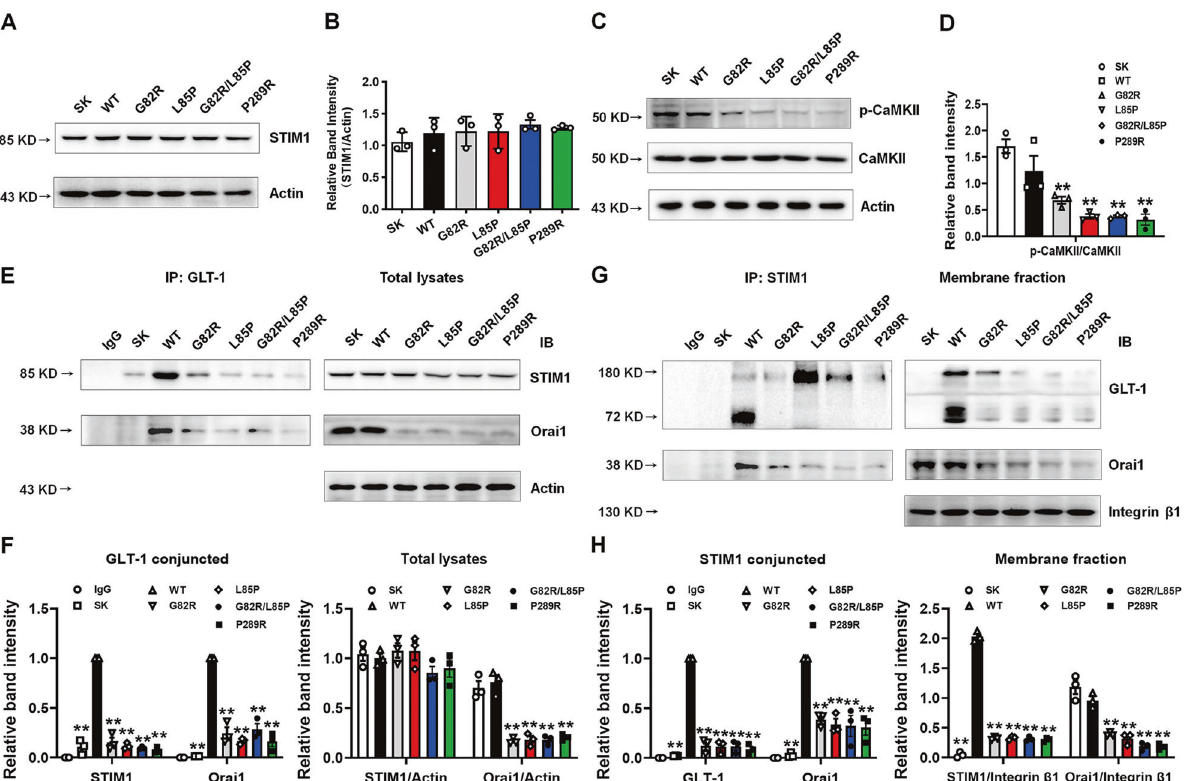
Fig. 4 Epileptic variants affected the STIM1/Orai1 complex. A , B The representative blots and quanti fi cation of STIM1 after transfection with different plasmids (SK, WT, G82R, L85P, G82R/L85P, and P289R) in HeLa cells were determined by Western blot. n = 3 per group. C , D The representative blots and quanti fi cation of the phosphorylation of CaMKII and total CaMKII after transfection with different plasmids in HeLa cells were determined by Western blot. n = 3 per group. E , F The interaction between GLT-1 and STIM1 or Orai1 was determined by a Co-IP assay using GLT-1 as the capture antibody. G , H The interaction between GLT-1 and STIM1 or Orai1 was determined by a Co-IP assay using STIM1 as the capture antibody. n = 3 per group. Results are expressed as mean ± SD. ** P < 0.01 vs. WT. Statistical signi fi cance was determined using one-way ANOVA and Tukey ’ s tests for post hoc